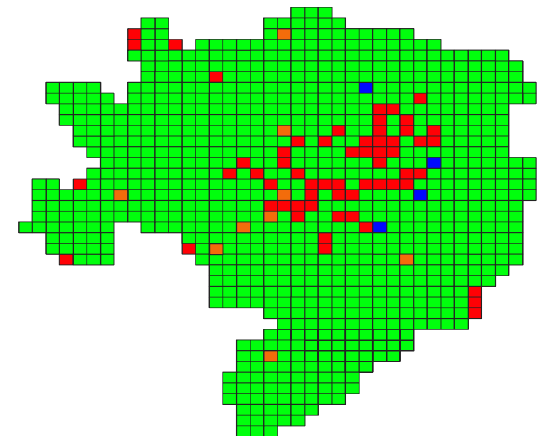
Figure 13. Squares available for PSs settlement: green are the squares able to accommodate a PS; red are the squares unable to accommodate a PS; blue is the squares that contain an MV substation without enough space for conversion into a PS, while the orange squares contain either an MV substation with enough space to be converted into a PS or the location of expected coming PSs, as indicated in the Unareti developing plan.